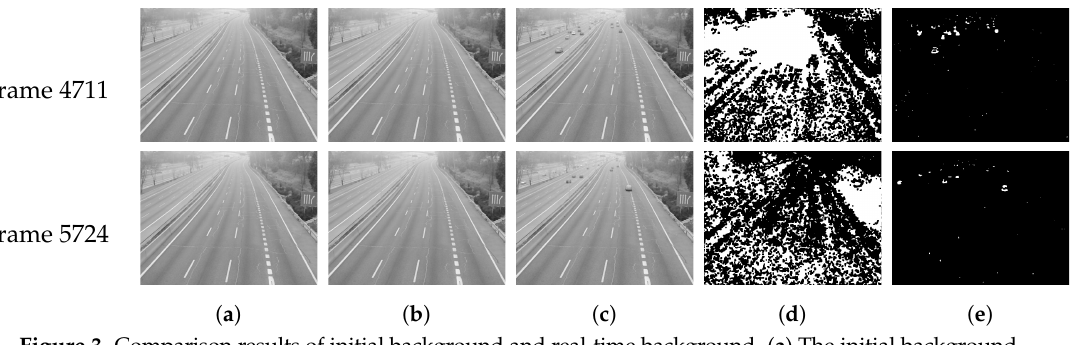
Figure 3. Comparison results of initial background and real-time background. ( a ) The initial background. ( b ) The real-time background. ( c ) The current frame. ( d ) The extraction of the foreground using initial background. ( e ) The extraction of the foreground using real-time